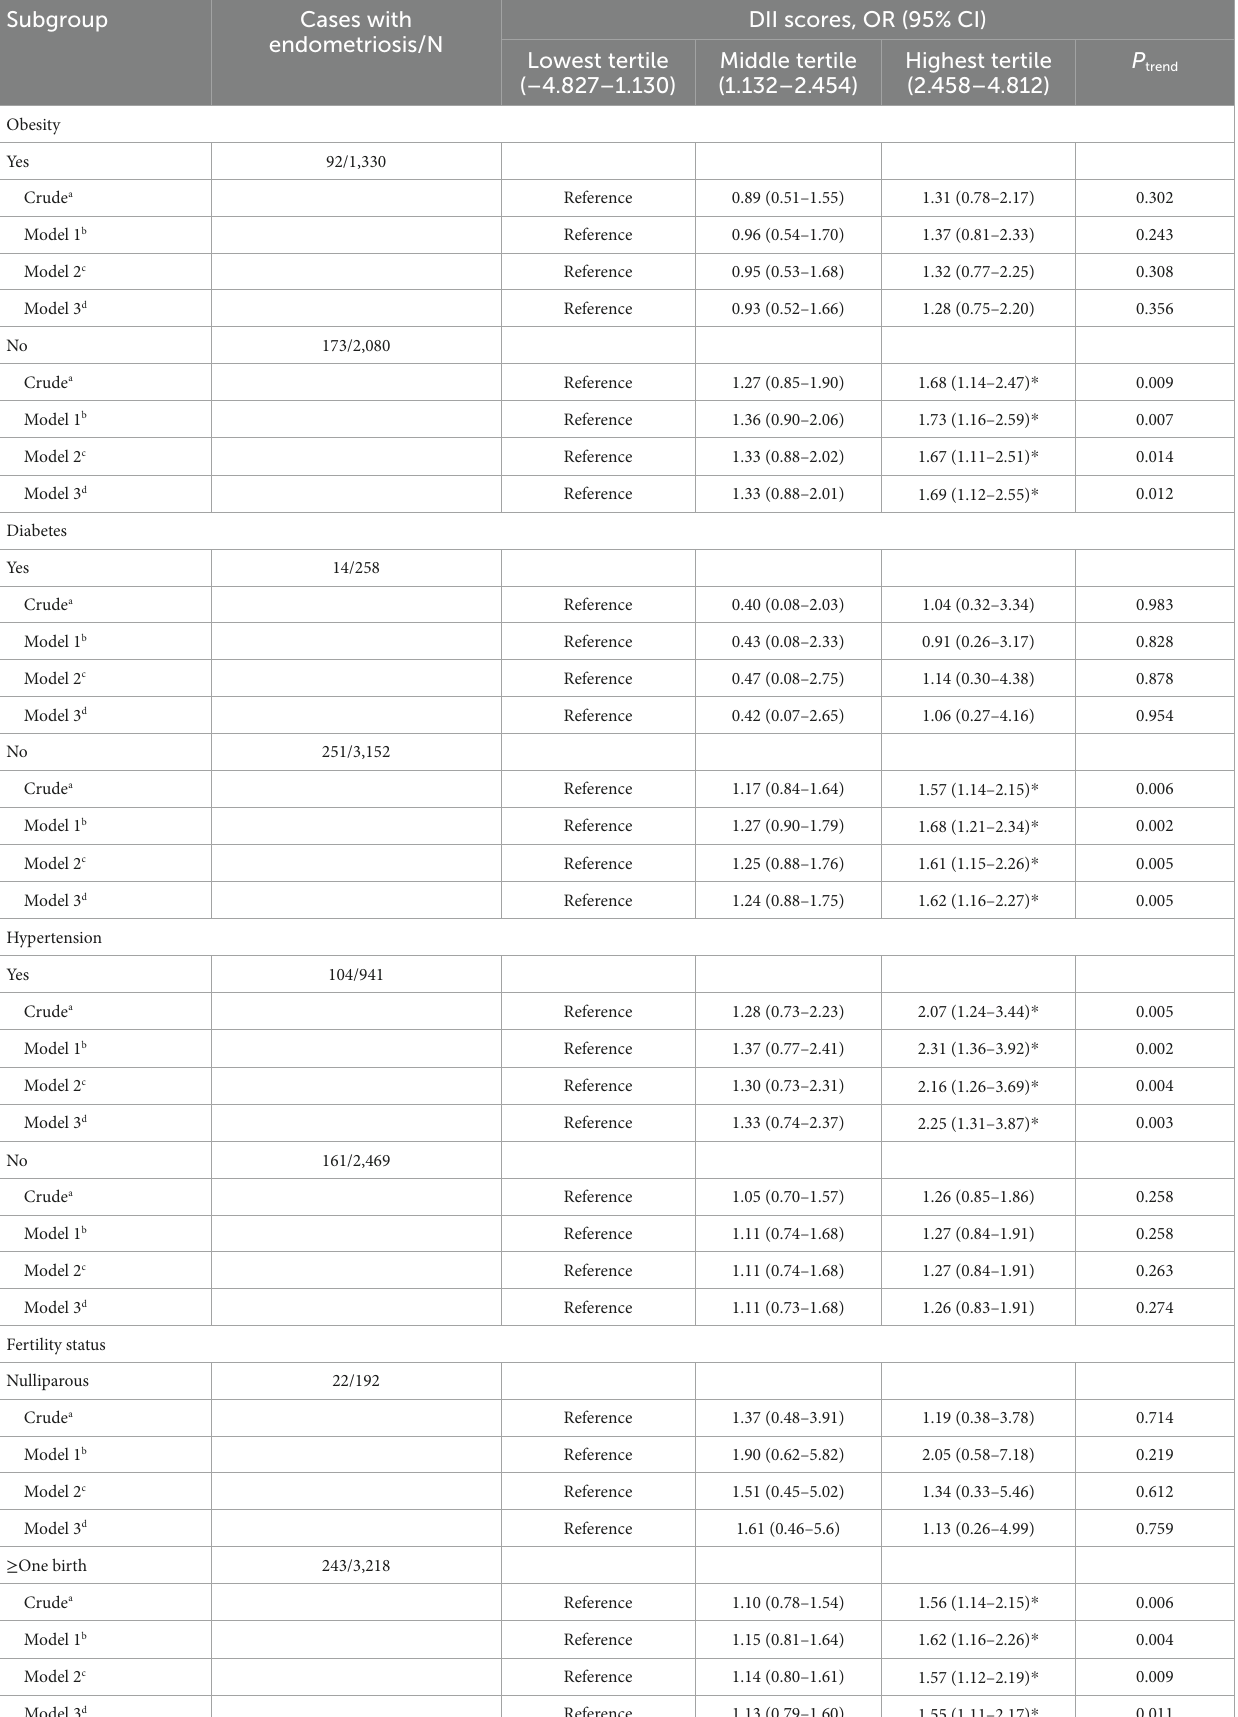
TABLE 3 Subgroup analysis of association between tertiles of DII scores and endometriosis. Subgroup Cases with